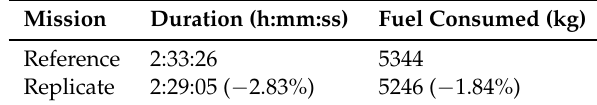
Table 5. Comparison of optimal top-level performance metrics of the validation mission